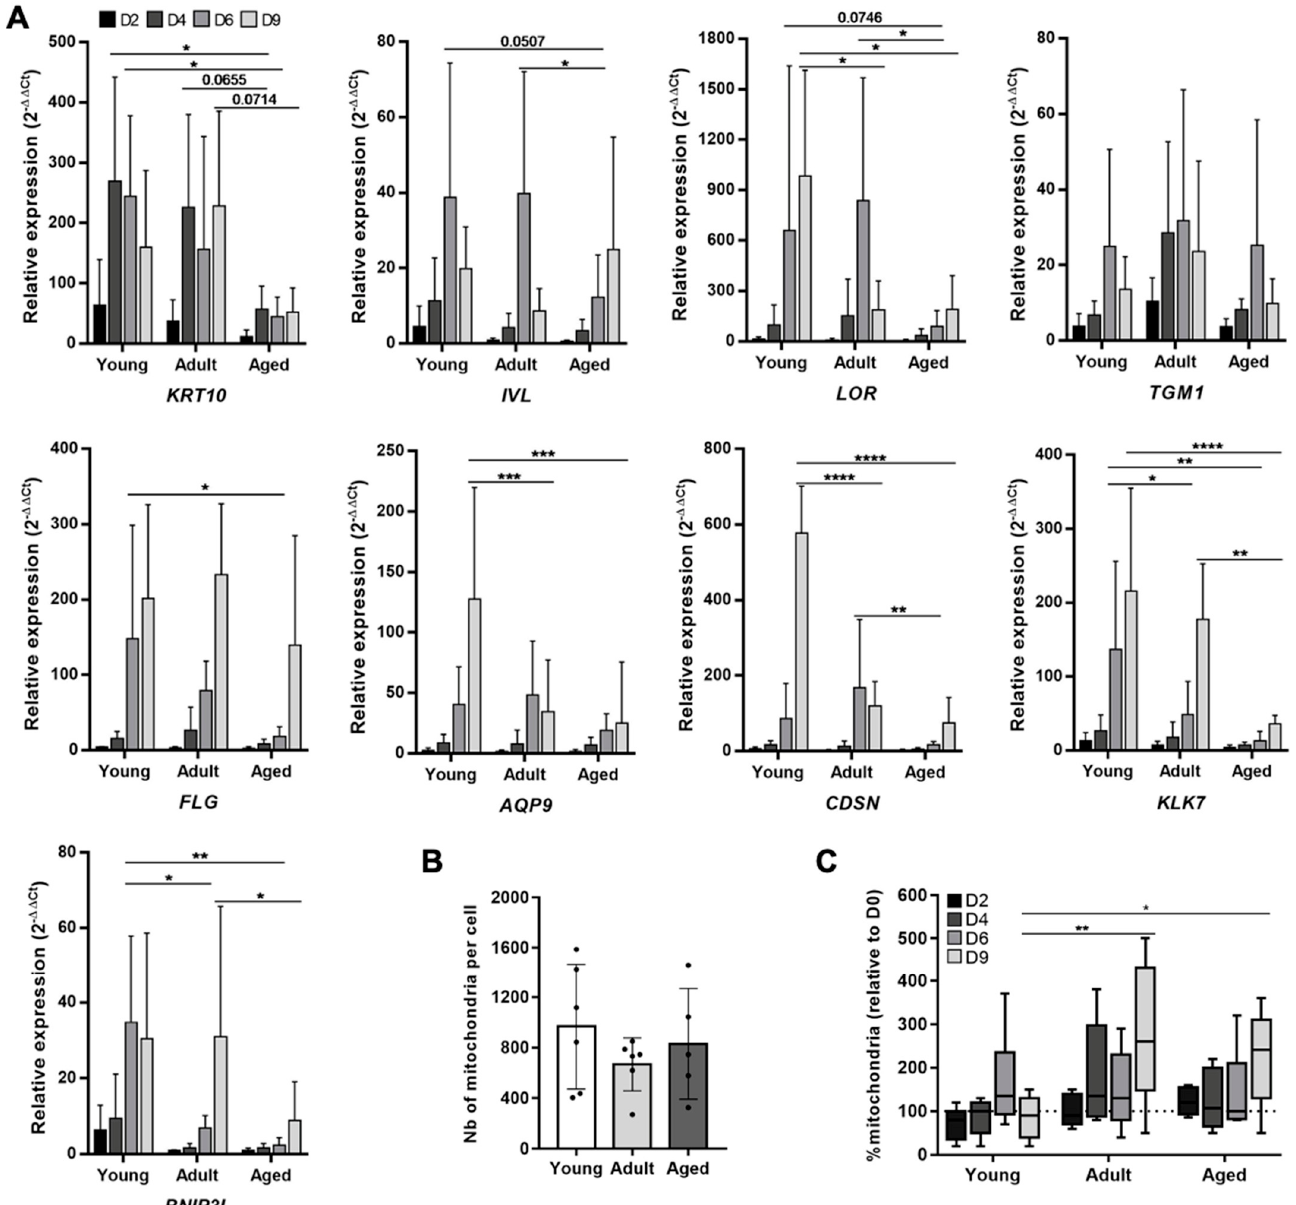
Figure 4. Human keratinocyte differentiation, BNIP3L expression and mitochondria retention in vitro with aging. ( A ) Relative mRNA expression of differentiation markers and BNIP3L in keratinocytes during a kinetic of differentiation in 2D culture. Three different age groups were tested (young group: n = 6, from 3 to 10 years old, mean age at 5; adult group: n = 6, from 26 to 46 years old, mean age at 36.5; aged group: n = 5, from 68 to 92 years old, mean age at 79) and followed over the time (0, 2, 4, 6 and 9 days after reaching confluency). qPCR analysis was normalized to TBP and RPL13A housekeeping genes (mean ± SD; * p < 0.05, ** p < 0.01, *** p < 0.001 and **** p < 0.0001). Exact p -values were determined using the two-way ANOVA and Tukey post-hoc tests. ( B ) Mitochondria content per cell estimated by qPCR at day 0. qPCR analysis was performed by normalizing the relative content of mitochondrial genes ( ND1 and TL1 ) with the content of nuclear genes ( HBB and SERPINA1 ) using the 2 − ∆∆ Ct quantification method in the three groups (mean ± SD; young group: n = 6; adult group: n = 6; aged group: n = 5). ( C ) Evolution of the content of mitochondria expressed as a percentage of the quantity at day 0 (median ± SD; * p < 0.05, ** p < 0.01). Exact p -values were determined using the two-way ANOVA and Tukey post-hoc